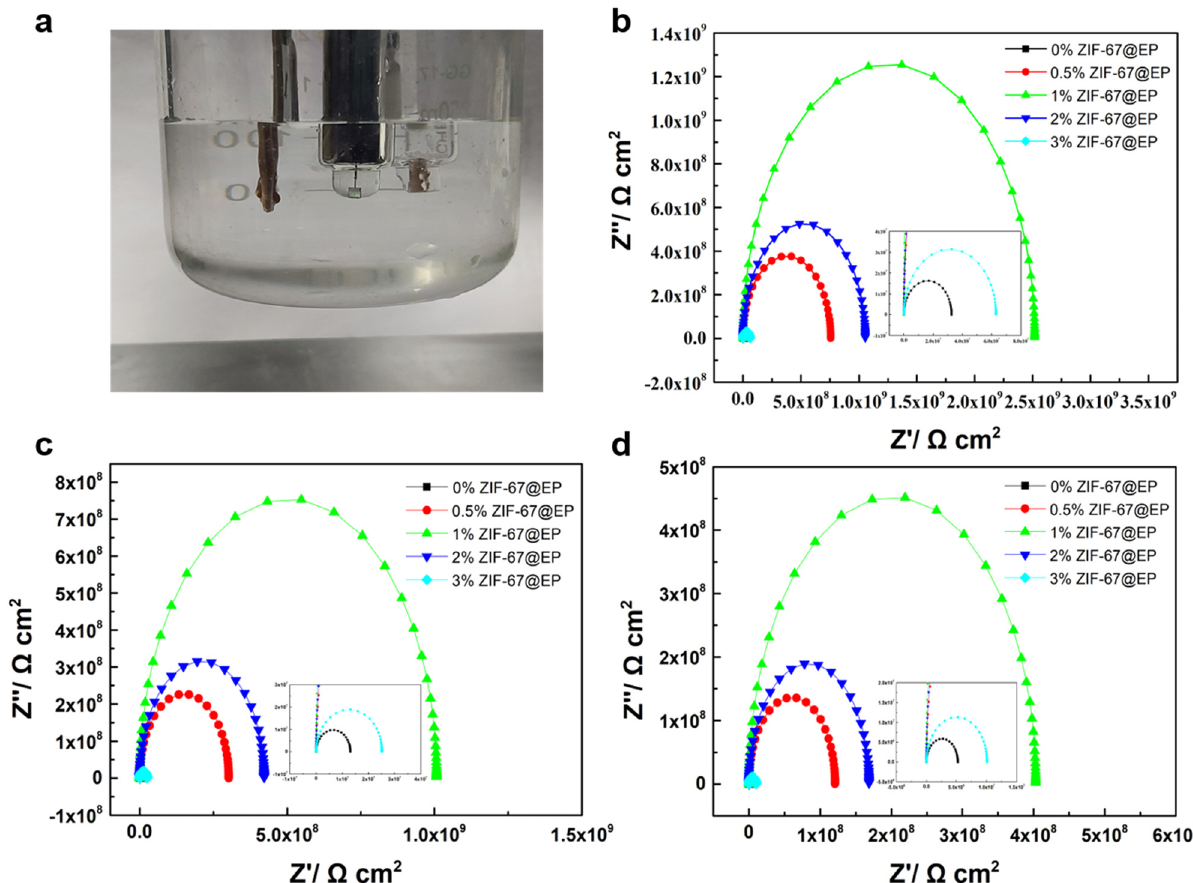
Figure 7: Three - electrode system ( a ) , Nyquist plots of composite coatings at di ff erent immersion times: 0 day ( b ) , 7 days ( c ) , and 14 days ( d )